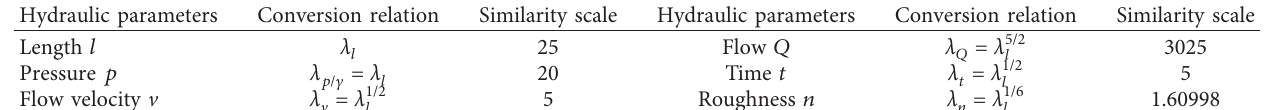
Table 1: Hydraulic parameter similarity under the condition of gravity similarity.